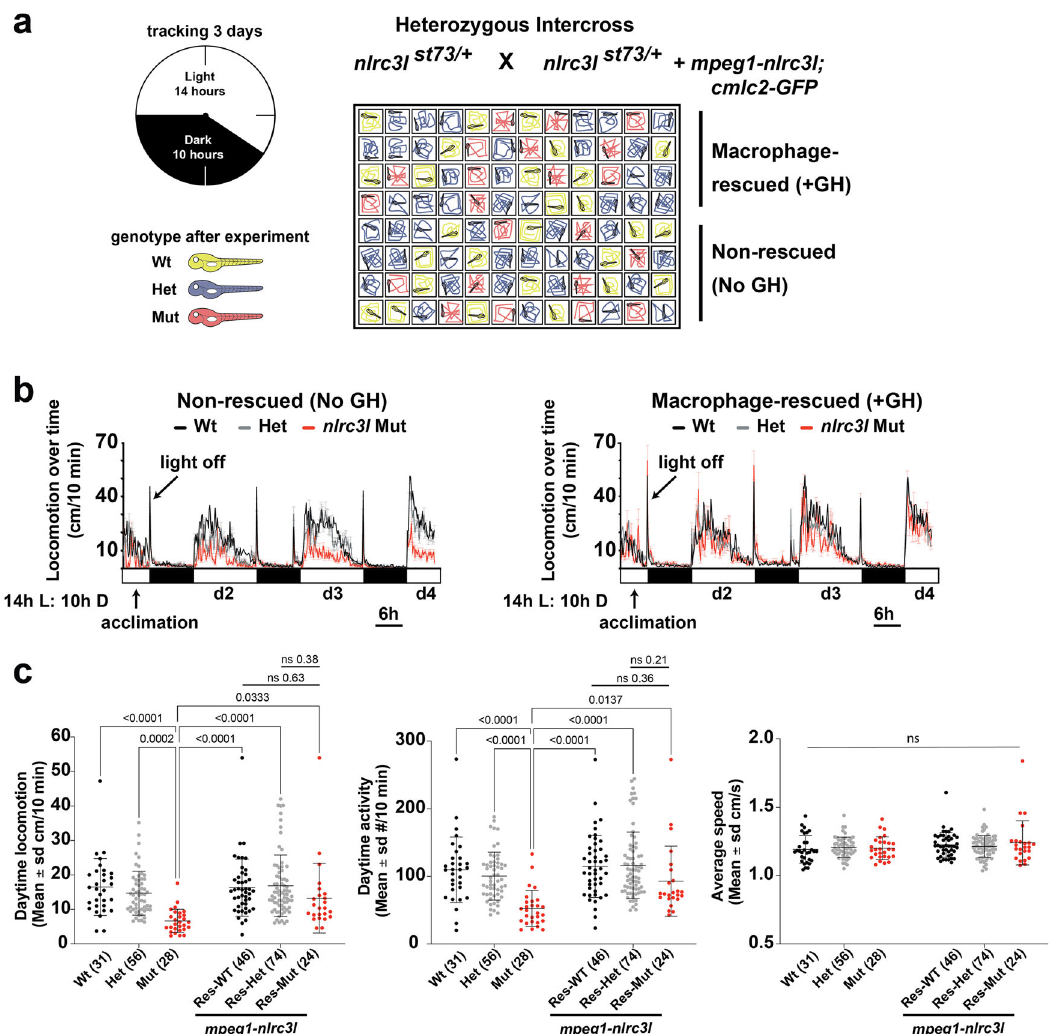
Fig. 3 Macrophage-speci fi c rescue of nlrc3l mutants is suf fi cient to reverse the de fi cient locomotor behavior. a Schematic of experimental setup to analyze locomotor behaviors of macrophage-rescued ( + GH) and non-transgenic non-rescued (No GH) sibling zebra fi sh side by side. b Time plots showing the ef fi cacy of the stable mpeg1-nlrc3l transgene to largely restore daytime locomotion in nlrc3l mutants from their reduced baseline level (shown in the non-rescued plot). The rescue transgene had no apparent effect on the heterozygous and wild-type siblings; no difference in locomotor behavior was found between siblings with and without the rescue transgene. c Scatter box-and-whisker plots showing no signi fi cant difference in daytime locomotion or activity in macrophage-rescued nlrc3l mutants compared with baseline wild-type siblings, while baseline nlrc3l mutants showed a signi fi cant reduction. n number of animals analyzed shown in parenthesis below each scatter plot. Three independent experiments were conducted to compare larvae derived from an nlrc3l heterozygous intercross with and without the macrophage rescue transgene on the same plate. Statistical signi fi cance was determined by two-way ANOVA test followed by multiple comparison tests. FDR-adjusted p -values are reported; ns, not signi fi cant as de fi ned by p -values > 0.05. All pairwise brackets not shown are ns, not signi fi cant. Res, individuals carrying the rescue